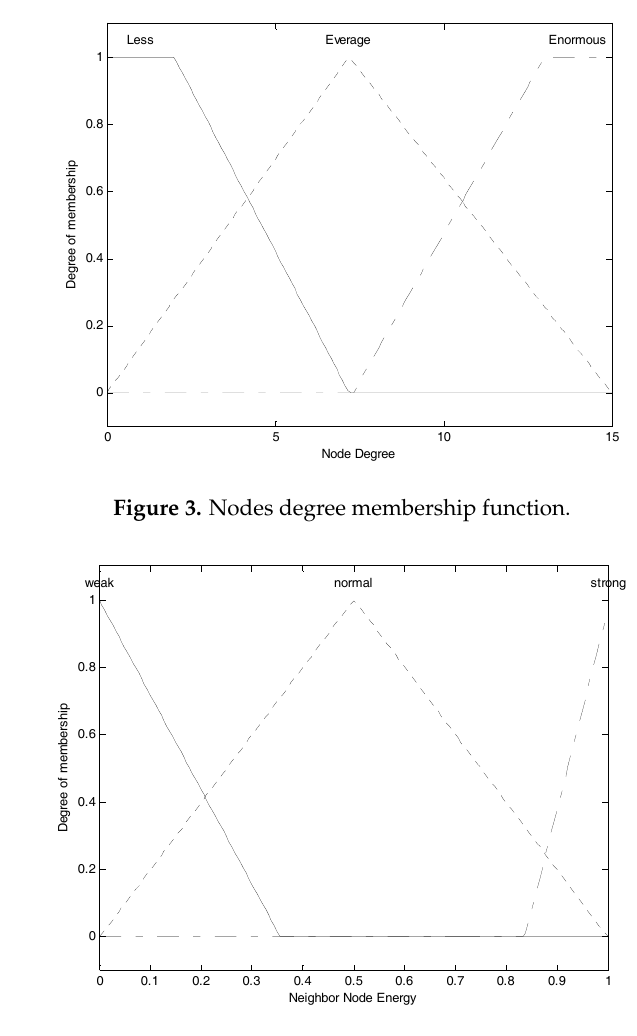
Figure 4. Neighbor nodes’ energy membership function.